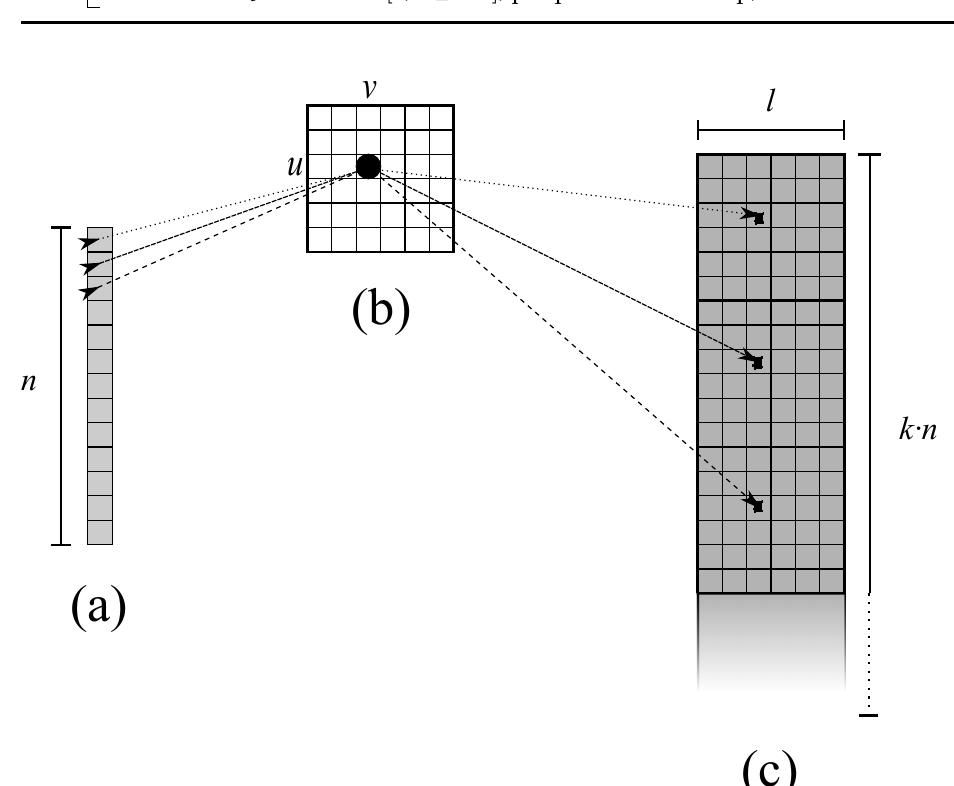
Figure 4. Graphical representation of d 2 configuration for patch centering on line 7 of Algorithm 2. ( a ) is the vector with mean values per patch, stored in a fast shared memory; ( b ) are threads t ( u , v ) , one per patch element; ( c ) is the strip of patches to be centered by subtracting corresponding mean